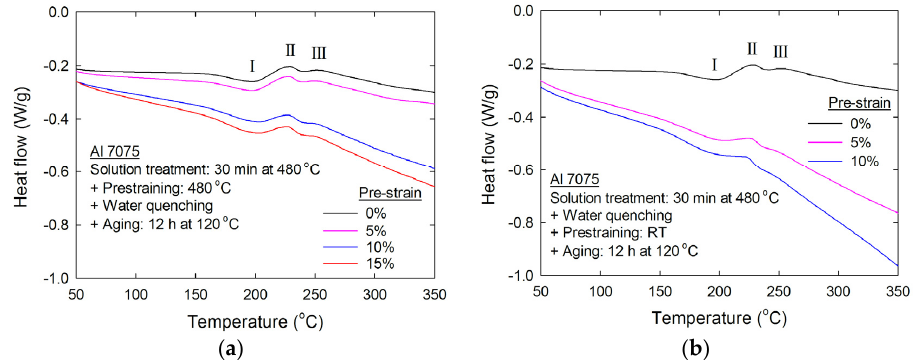
Figure 8. The DSC curves for the Al 7075 with pre-straining at ( a ) 480 °C and ( b ) RT where the plots include the DSC curve for the Al 7075-T6 without pre-straining. include the DSC curve for the Al 7075-T6 without